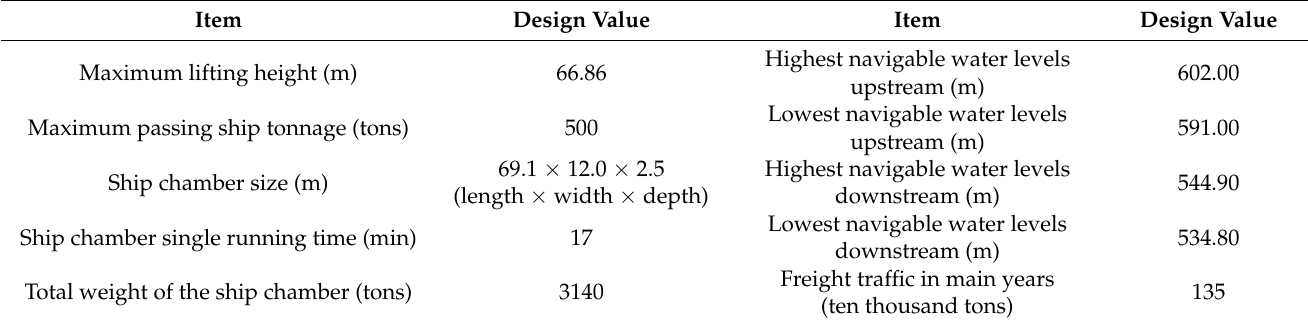
Figure 1. Jinghong conservancy project: ( a ) top view and ( b ) upstream view of ship lift. Table 1. Design parameters of Jinghong hydro-floating ship lift.